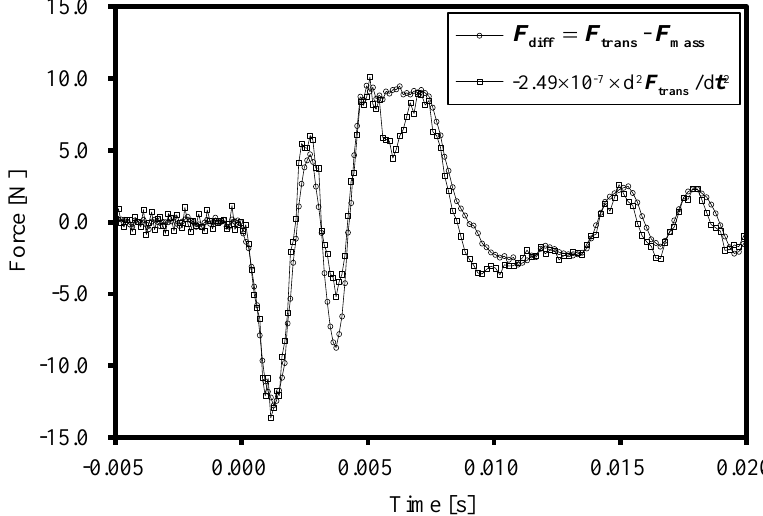
and F and estimated inertial force of the trans mass